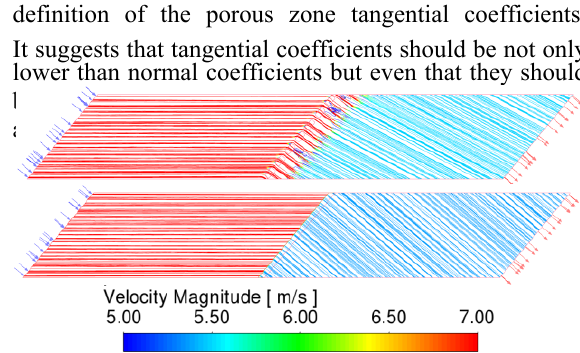
Streamlines of air flow through perforated plate (top) and porous zone (bottom) coloured by pressure - impact angle 40°